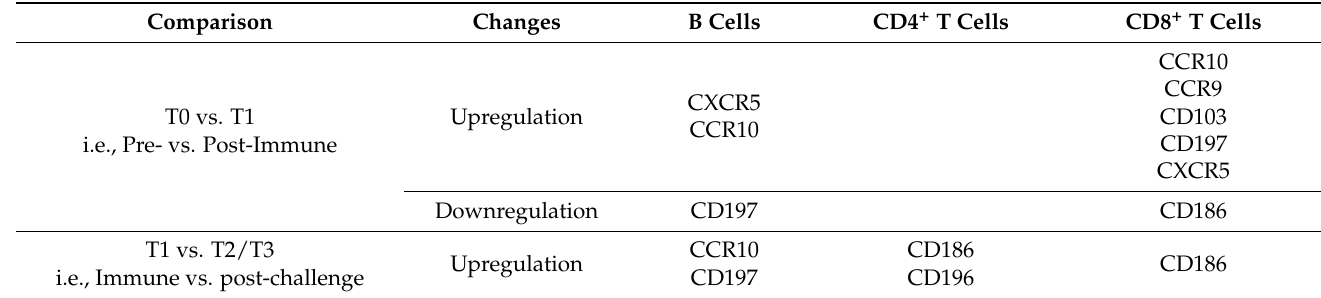
Table 2. Summary of significant changes in homing receptor